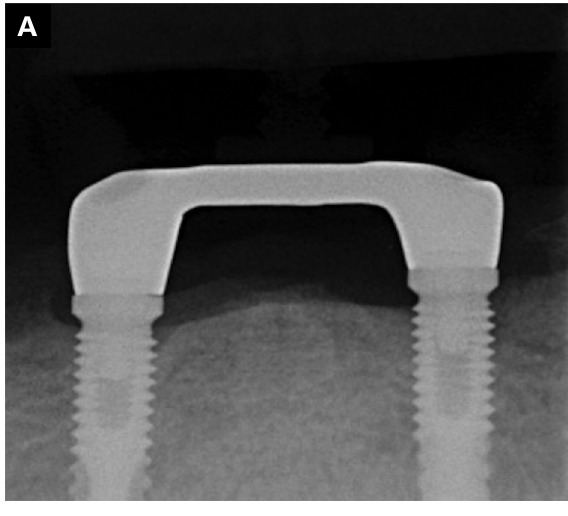
Figure 1A. A Radiographic view at